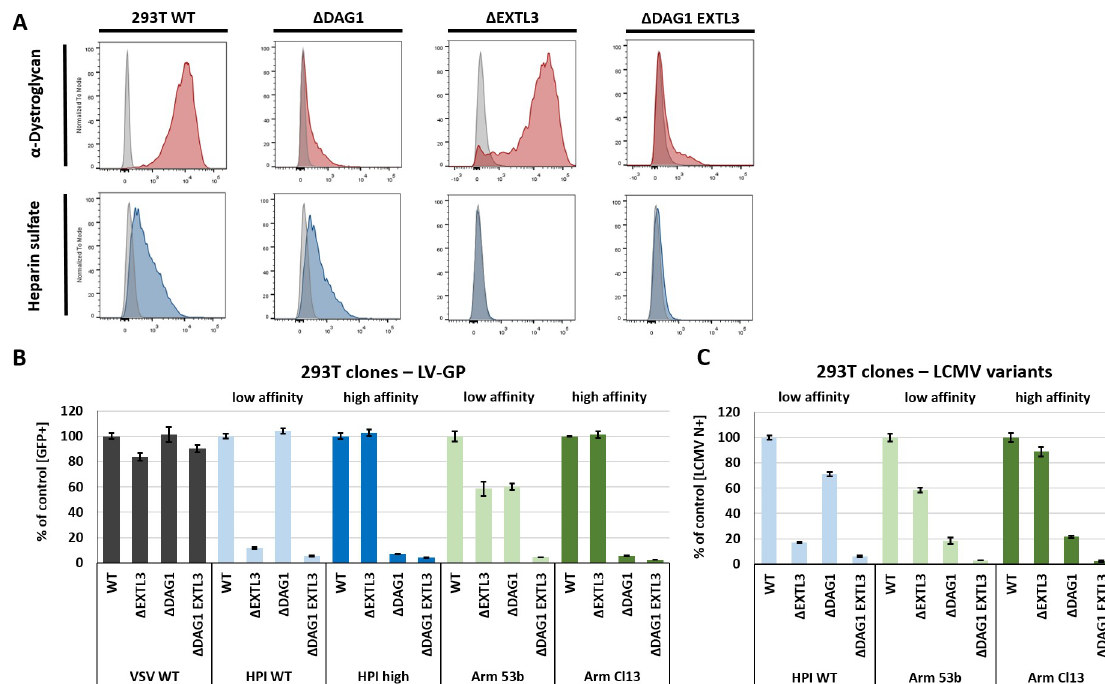
Fig 2. Lack of HS after EXTL3 knockout reduces LCMV infection. (A) Flow cytometry analysis of Dystroglycan-1 (IIH6; red) and Heparan sulfate (10E4; blue) expression in 293T WT, Δ DAG1 , Δ EXTL3 , and Δ DAG1 EXTL3 cells generated by CRISPR Cas9-mediated knockout. (B) Infection assay using a lentiviral (LV) reporter system encoding eGFP. LVs were pseudotyped with VSV-G, as a control, and low (HPI WT Y155H or Arm 53b L260F) or high (HPI high H155Y or Arm Cl13 260L) affinity LCMV GP variants. Cells were transduced with an MOI of 1 (determined for 293T WT) and eGFP signal was measured 72 h later by flow cytometry. (C) Infection assay with low (WE HPI or Arm 53b) and high (Arm Cl13) affinity variants of LCMV in different knockout variants of 293T cells. The cells were infected with an MOI of 1 (determined by semi-functional quantitative flow cytometry assay[55] for 293T WT cells) for 2 h at 37˚C and 16 h p.i. quantified by flow cytometry via LCMV N-staining. Shown are the means ± SD of three replicates.